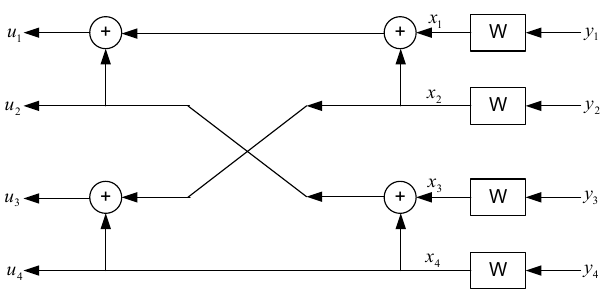
Figure 4: Polar decoding unit for 𝑁 = 4 .